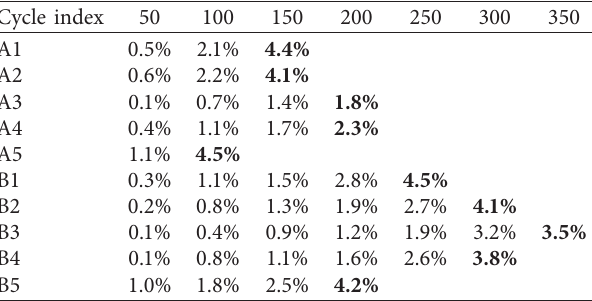
Table 8: Mass loss rate of iron tailings powder concrete in different freeze-thaw